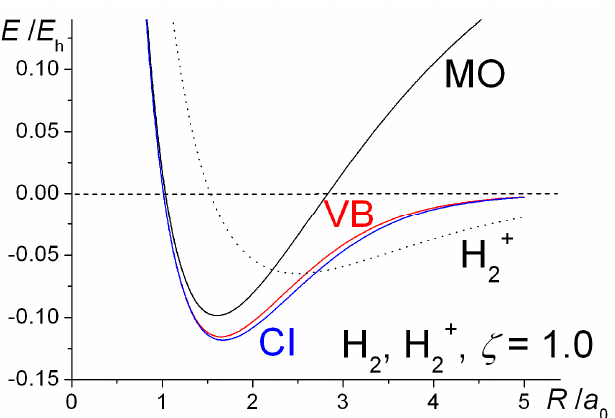
Figure 13. The bond energy curves of H 2 (relative to the energy of two hydrogen atoms) computed in a minimal basis of two hydrogen AOs with a fixed exponent of 1, as obtained by the MO, VB and CI methods (solid lines), and comparison with the energy curve of H 2 + (dotted line)—all relative to the energy of a H atom.